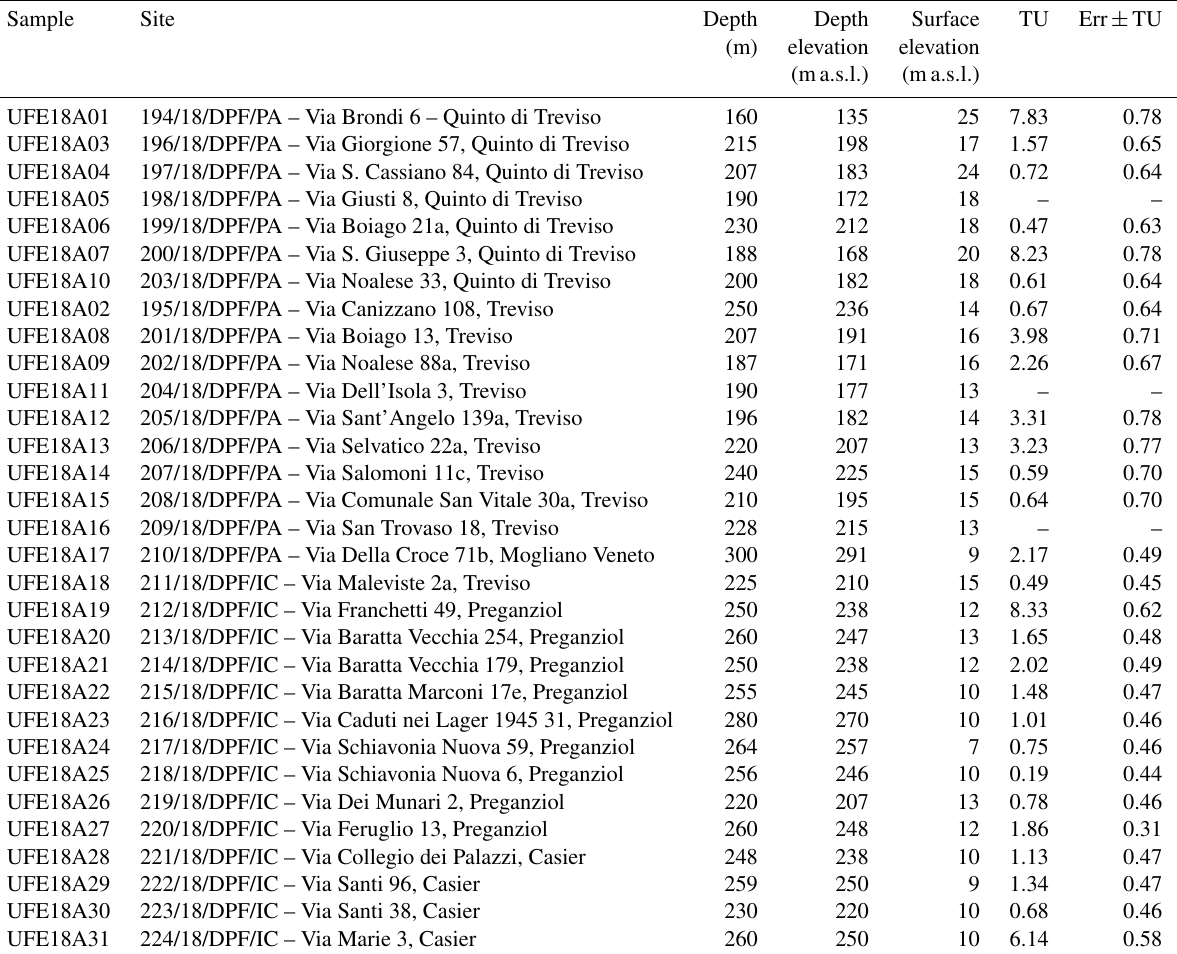
Table 1. Tritium concentration (expressed in tritium unit TU) for each sample of water collected, listed for similar sampling site: Quinto di Treviso, Treviso, Preganziol and Casier. In addition, the depth of the wells and the surface elevation (ma.s.l.) are shown (ARPAV report,